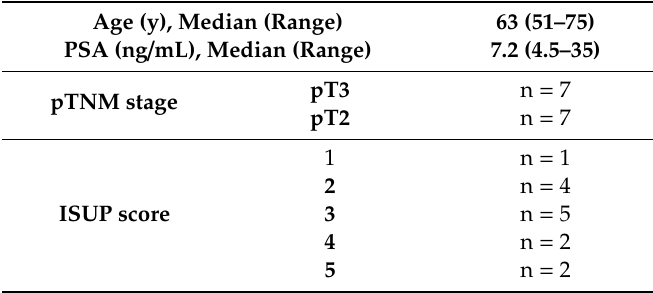
Table 1. Characteristics of patients and